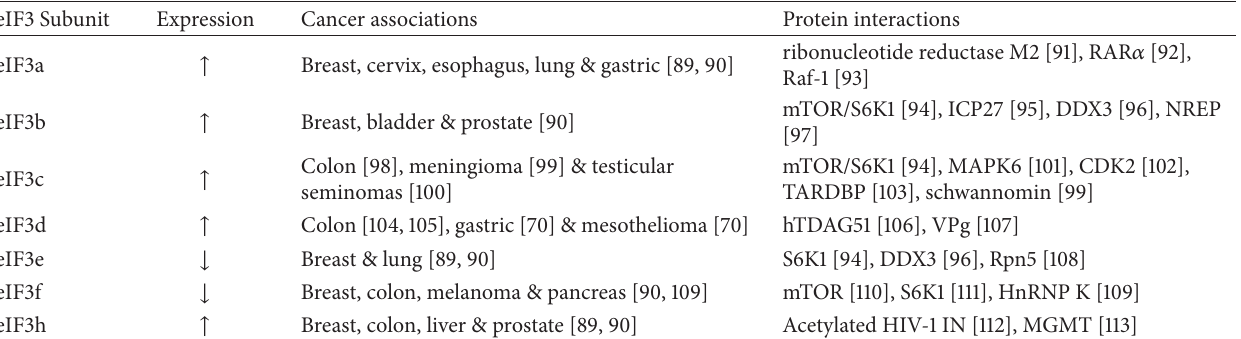
Table 1: Differential expression of eIF3 subunits in human cancers and notable eIF3-protein interactions. eIF3